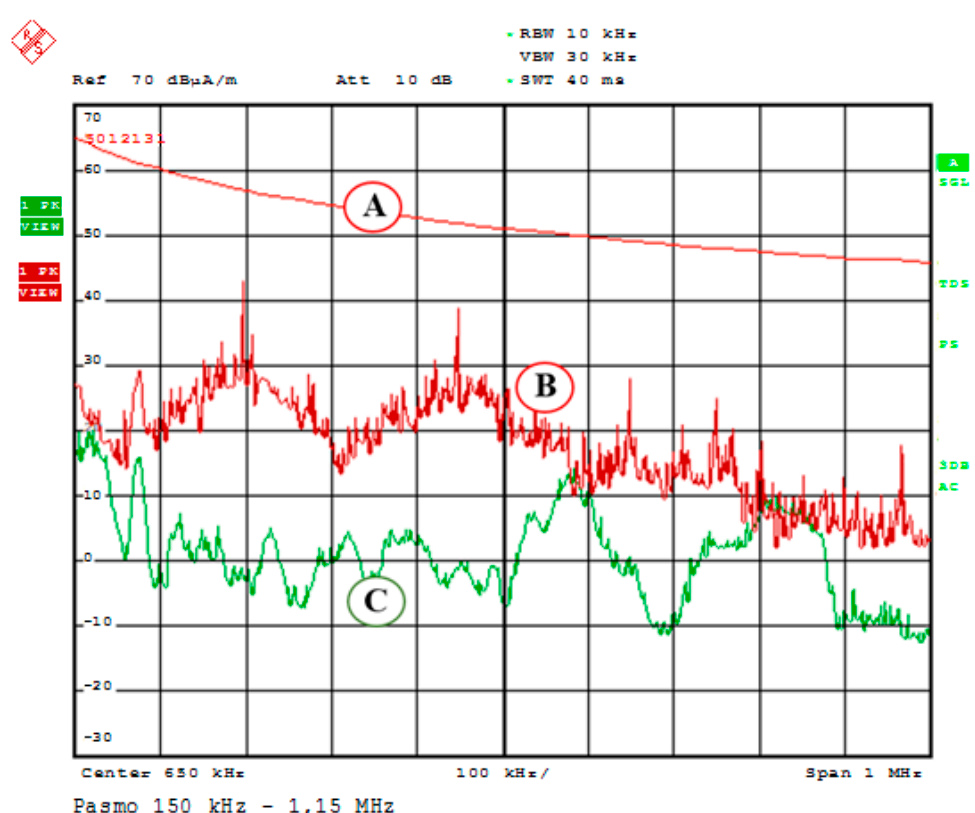
Figure 9. Spectrum of interfering signals radiated by a rail vehicle travelling at a speed of 50 km/h and the electromagnetic background for a frequency range of 150 kHz–1.15 MHz.